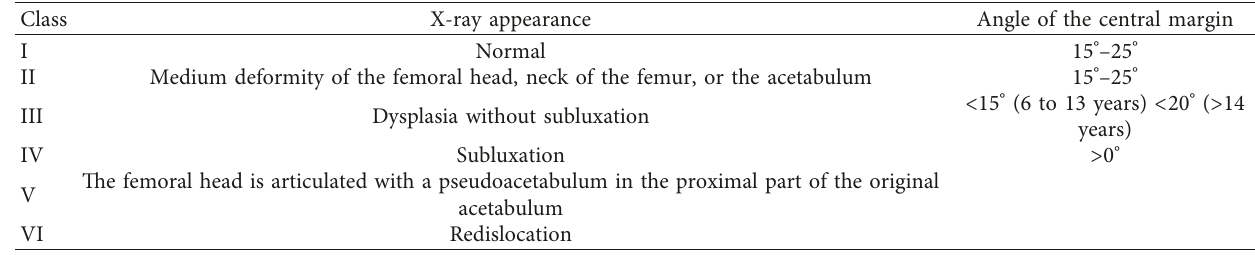
Table 2: Basic Severin classification system.